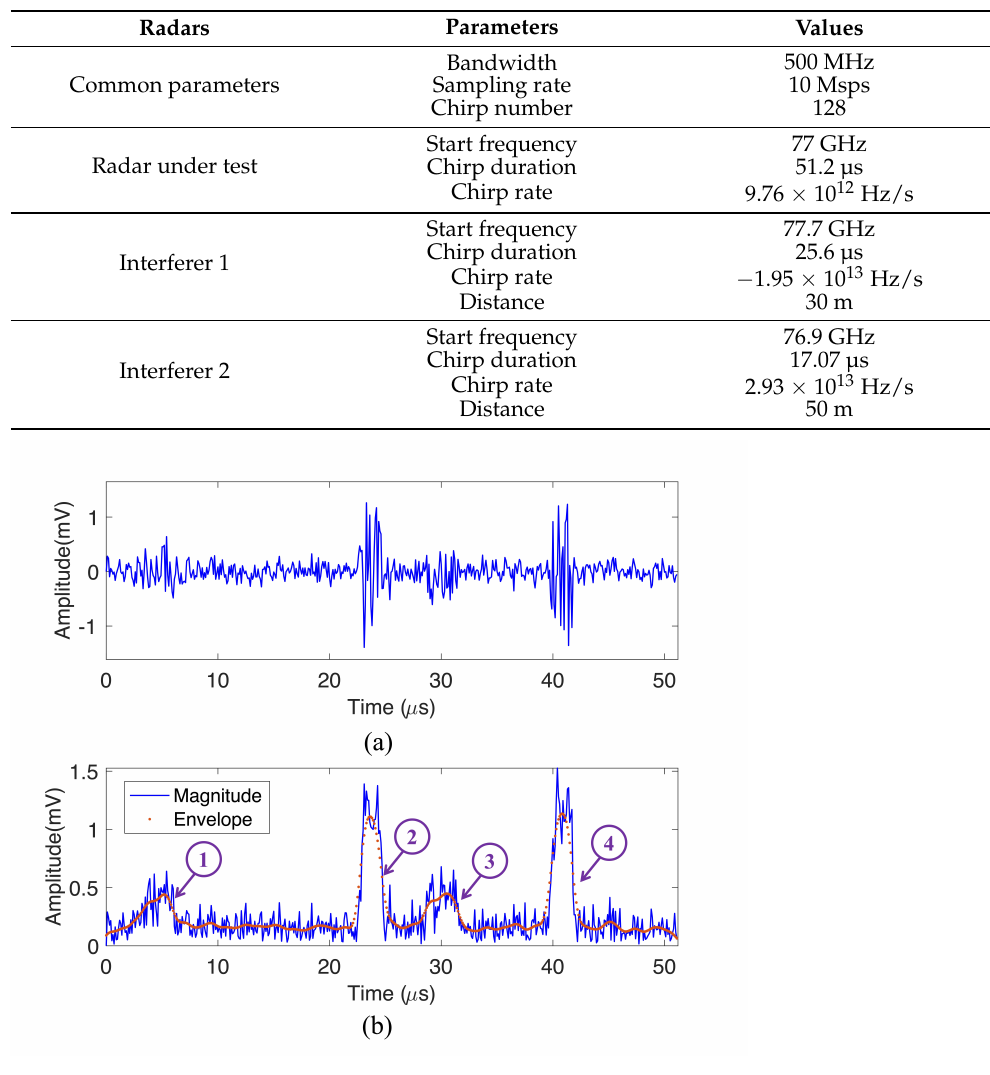
Figure 6. The received signal with interference: ( a ) the real part of the received signal and ( b ) the magnitude of the received signal. The regions marked by circles in ( b ) are the envelopes in which interference